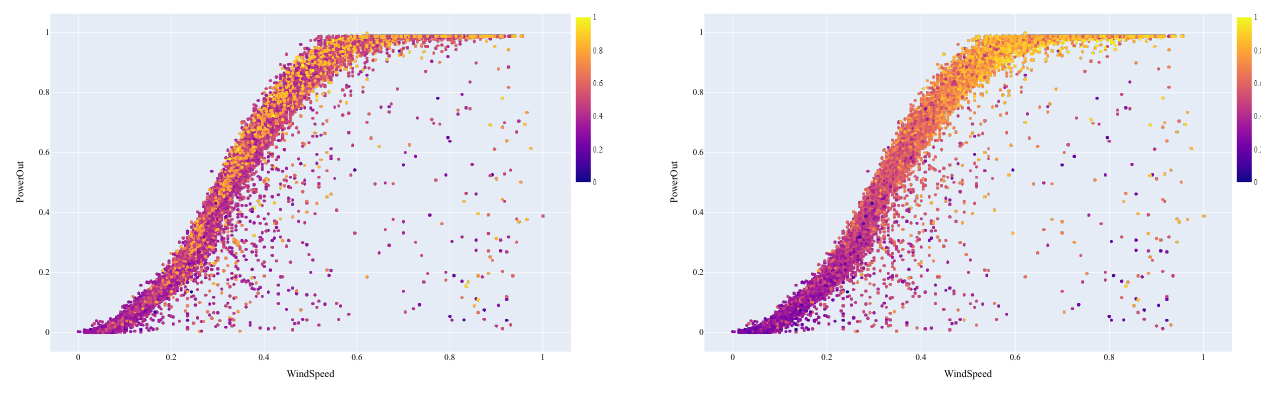
Figure 2. Power curves.